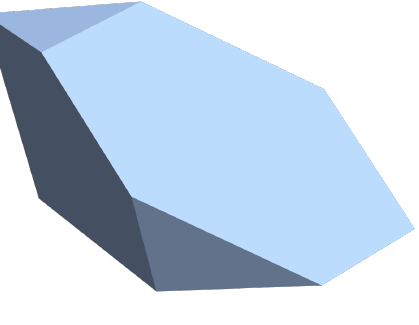
Figure 15. A degenerate cluster polytope of A 2 , 1 corresponding to the tropicalization of f 4 and f 5 in eq. (4.8) along with eq.